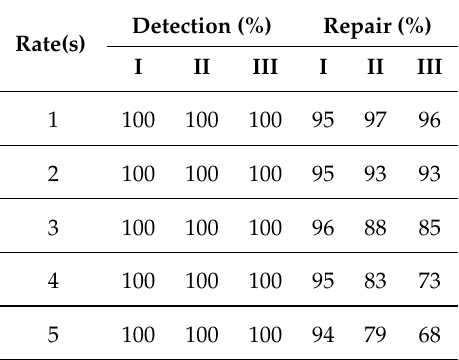
Table 5. The results of detected and corrected of the cycle slip over all stations for the three different methods in case 3.